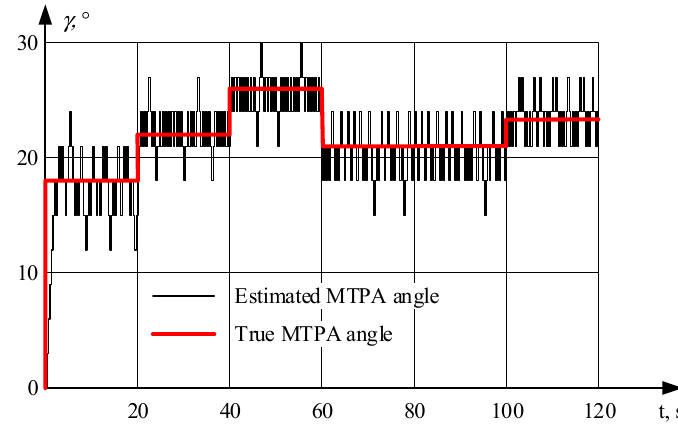
Energies 2020 , 13 , 5071 Figure 10. MTPA angle defined at 900 rpm with N = 15. Figure 10. MTPA angle defined at 900 rpm with N = 15.